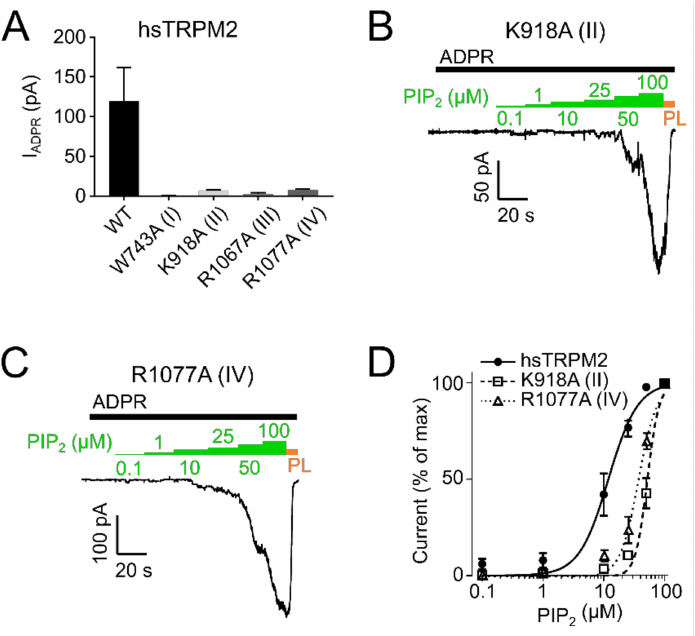
Figure 5. PIP 2 sensitivity of hsTRPM2 membrane interfacial cavity mutant channels. ( A ) Current amplitudes of wild-type and mutant hsTRPM2 channels in response to 300 µ M ADPR. Represen- tative current trace of K918A (II) ( B ) and R1077A (IV) ( C ) exposed to increasing PIP 2 (green bar) concentrations in the presence of 300 µ M ADPR (black bar). 15 µ g/mL polylysine (PL, orange bar) was used to block PIP 2 mediated currents. ( D ) Data summary of PIP 2 dose-response experiments showing a clear right shift of mutants K918A (II) and R1077A (IV) compared with the wild-type. Data presented as mean ± SEM; n =